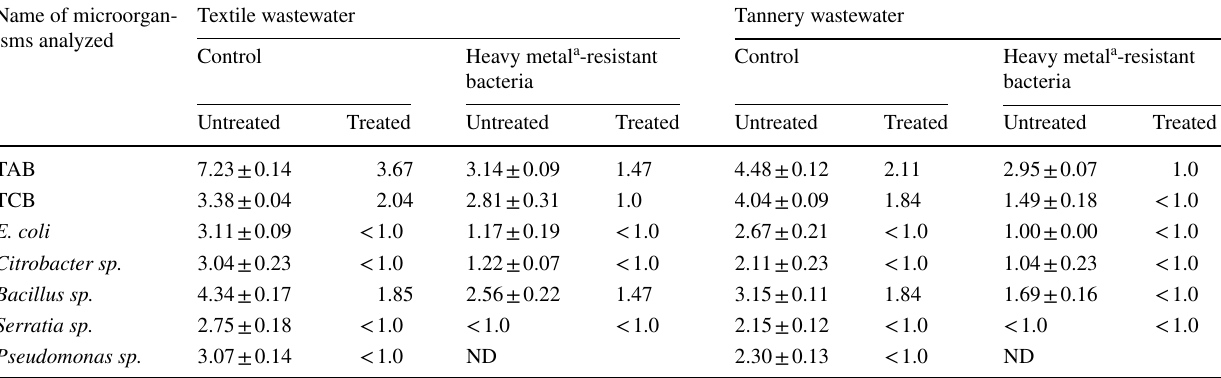
Table 2 Distribution of bacterial population (log CFU/ml) of treated (MSP and WSP in combination) and control textile and tannery effluent water